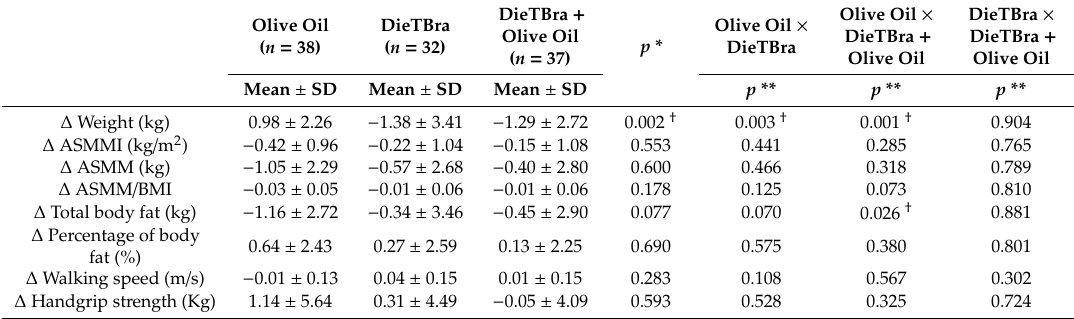
Table 4. Delta (e ff ectiveness) of outcome variables according to intervention groups and paired comparison. Olive Oil DieTBra ( n = 38) ( n = 32)